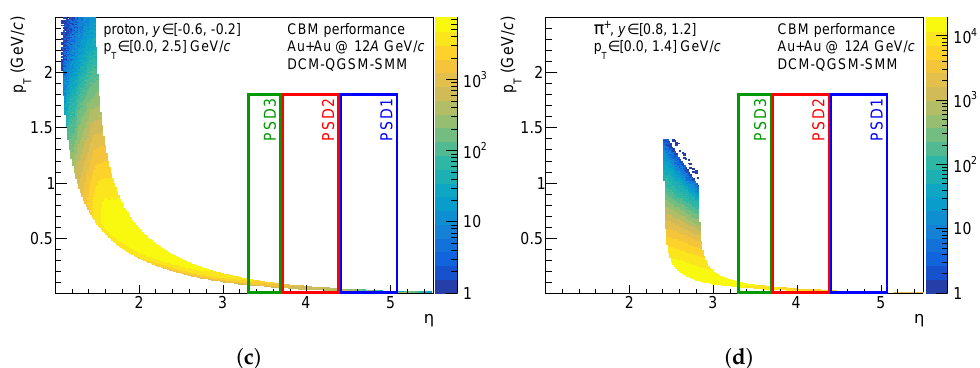
Figure 2. The distribution of tracks identified as ( a ) protons and ( b ) positively charged pions vs. p T and y . Red boxes mark the kinematic selection for the corresponding Q -vector subevents. ( c , d ): comparison of the acceptance for the five (two STS and three PSD) subevents used in the performance studies. See text for